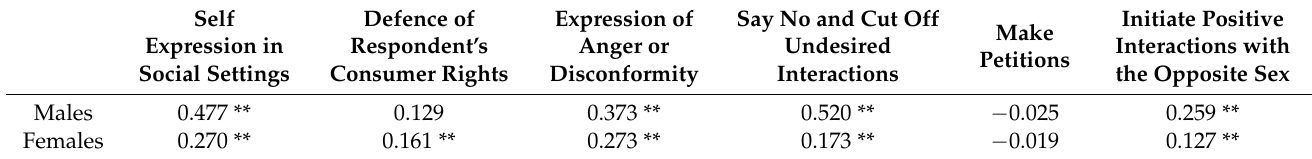
Table 2. Correlations between social skills and happiness by gender.